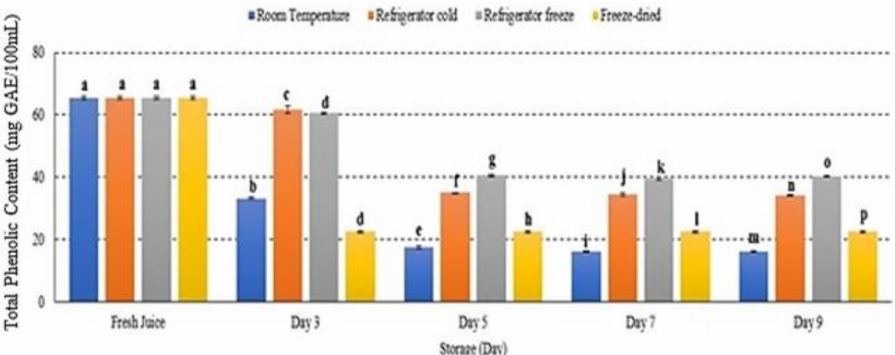
Figure 8. The total phenolic content in watermelon juice. Different letters indicate significant differences between samples p <